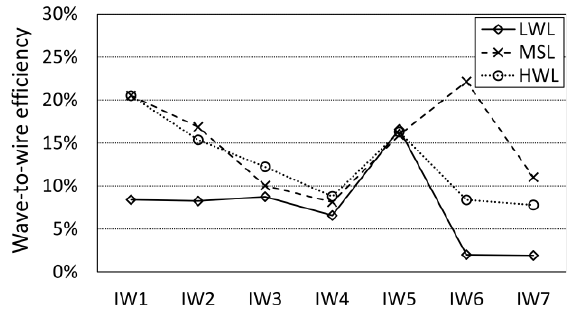
Fig. 15. Wave-to-wire efficiency of the OTD